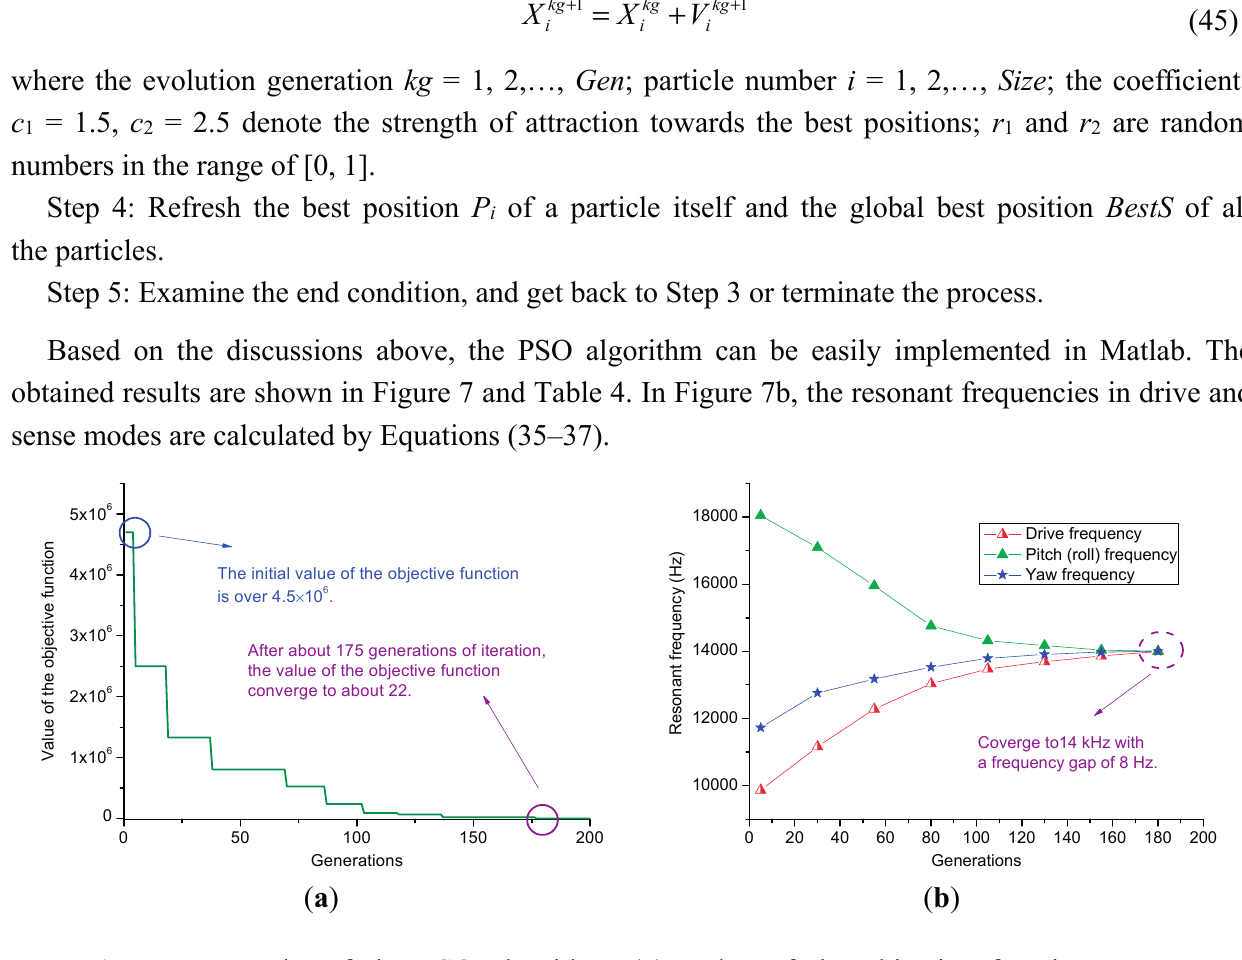
Figure 7. Results of the PSO algorithm. ( a ) Value of the objective function versus generations; ( b ) Resonant frequencies obtained by calculation versus generations. Table 4. The optimized values of the variables in PSO